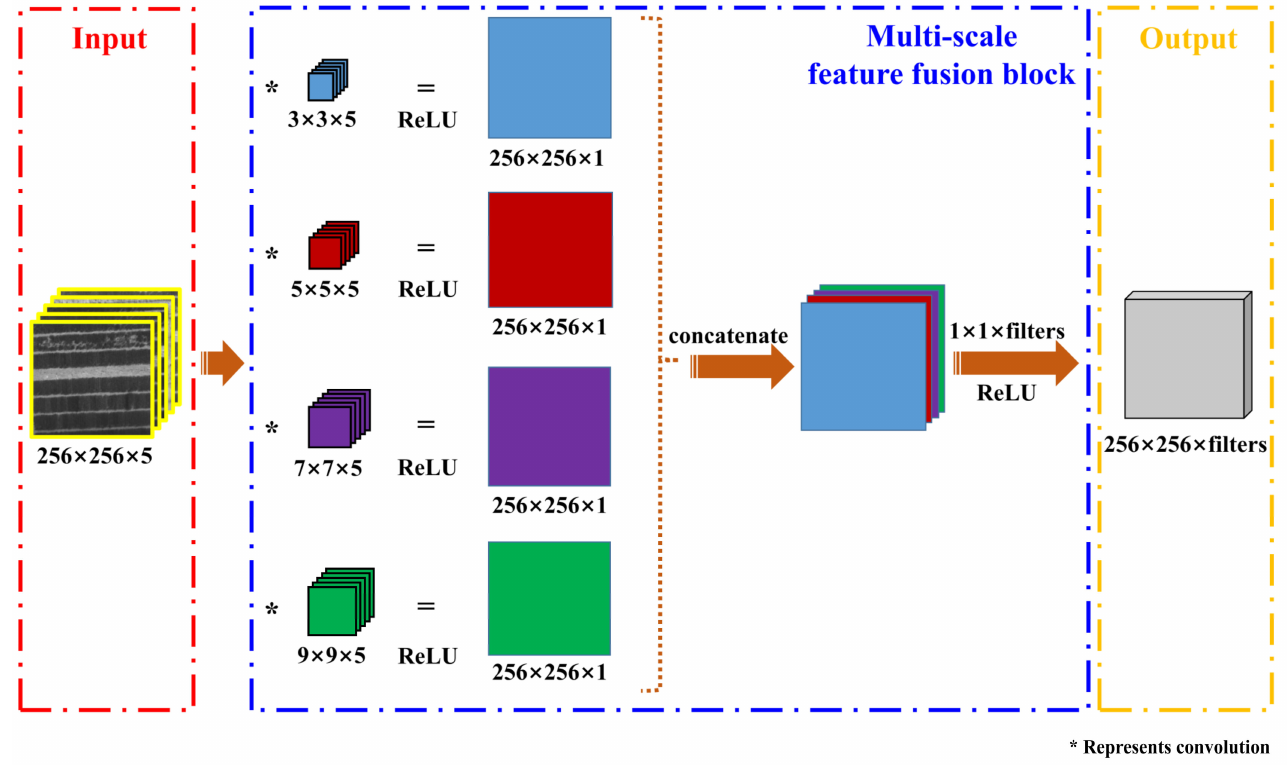
Figure 11. Multi-scale feature fusion